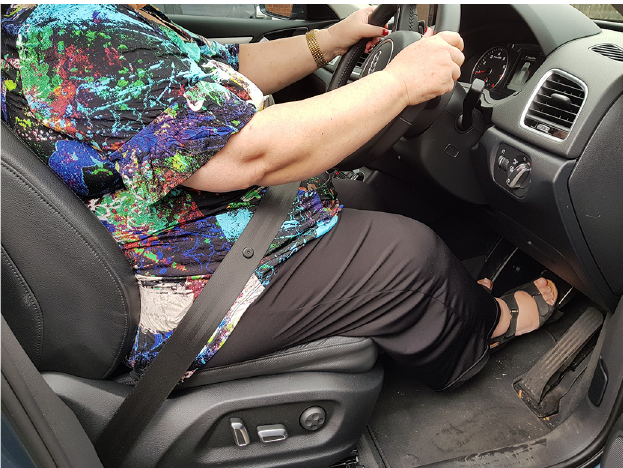
Figure 4. Patient in driving seat 2 weeks after anterior THA with hip fl exion (72 ° ), knee fl exion (40 ° ) and ankle in neutral position while